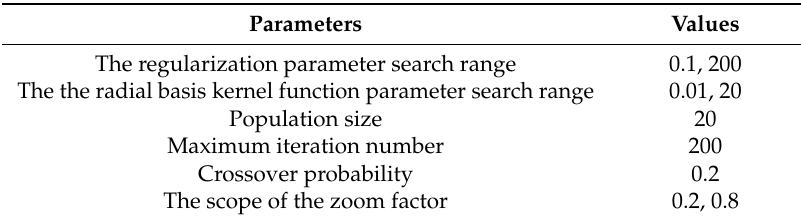
Table 3. The DE-GWO-SVM main